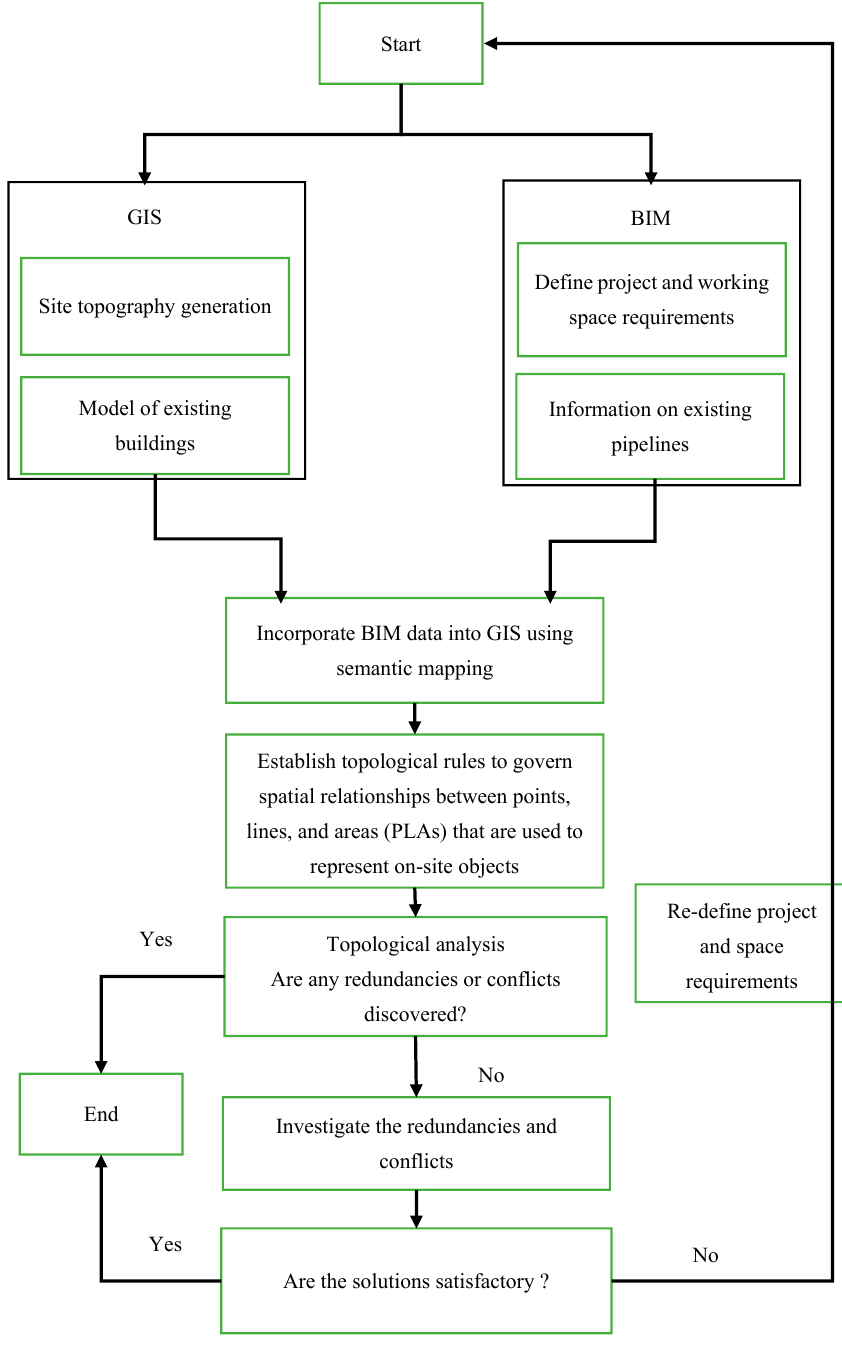
Figure 1. The process of the proposed method.